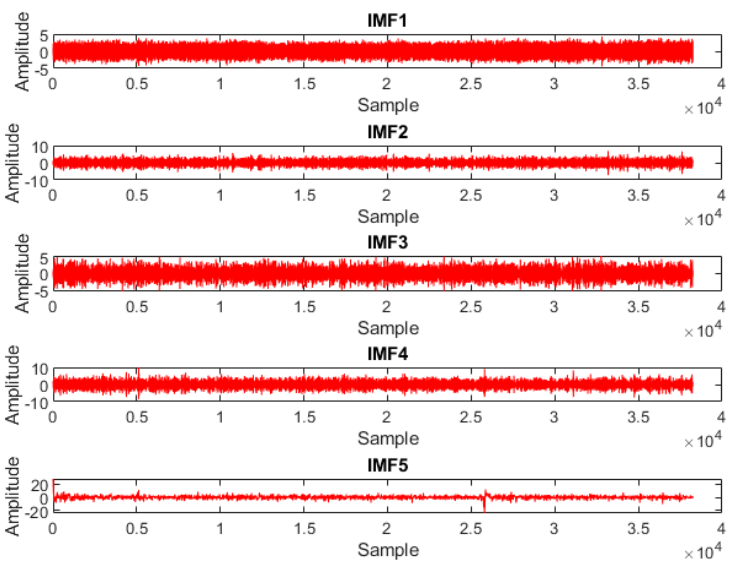
Figure 4. First five IMFs using VMD of the F4 EEG channel belonging to the subject number 10 (according to the G1 label).